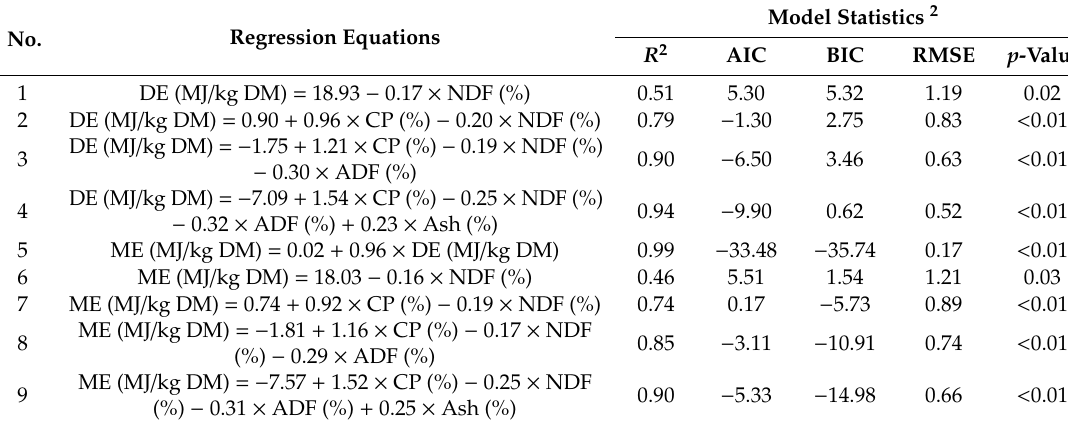
Table 12. Regression equations for digestible energy (DE) and metabolizable energy (ME) in wheat bran from and chemical characteristics 1 .